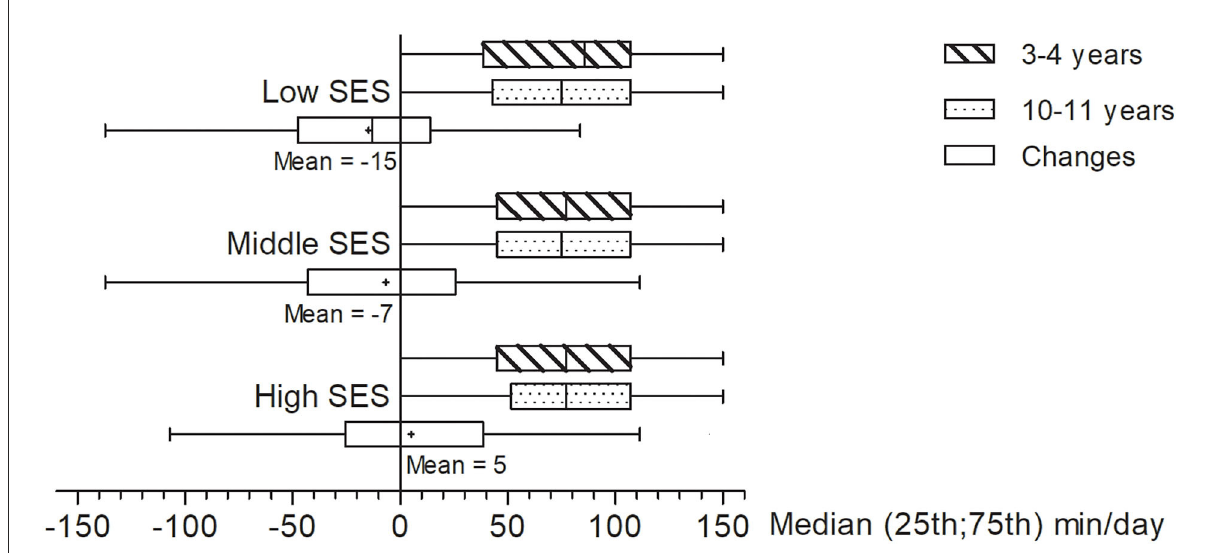
FIGURE3 Daily time spent on outdoor play at different ages, and changes in outdoor play, according to socioeconomic